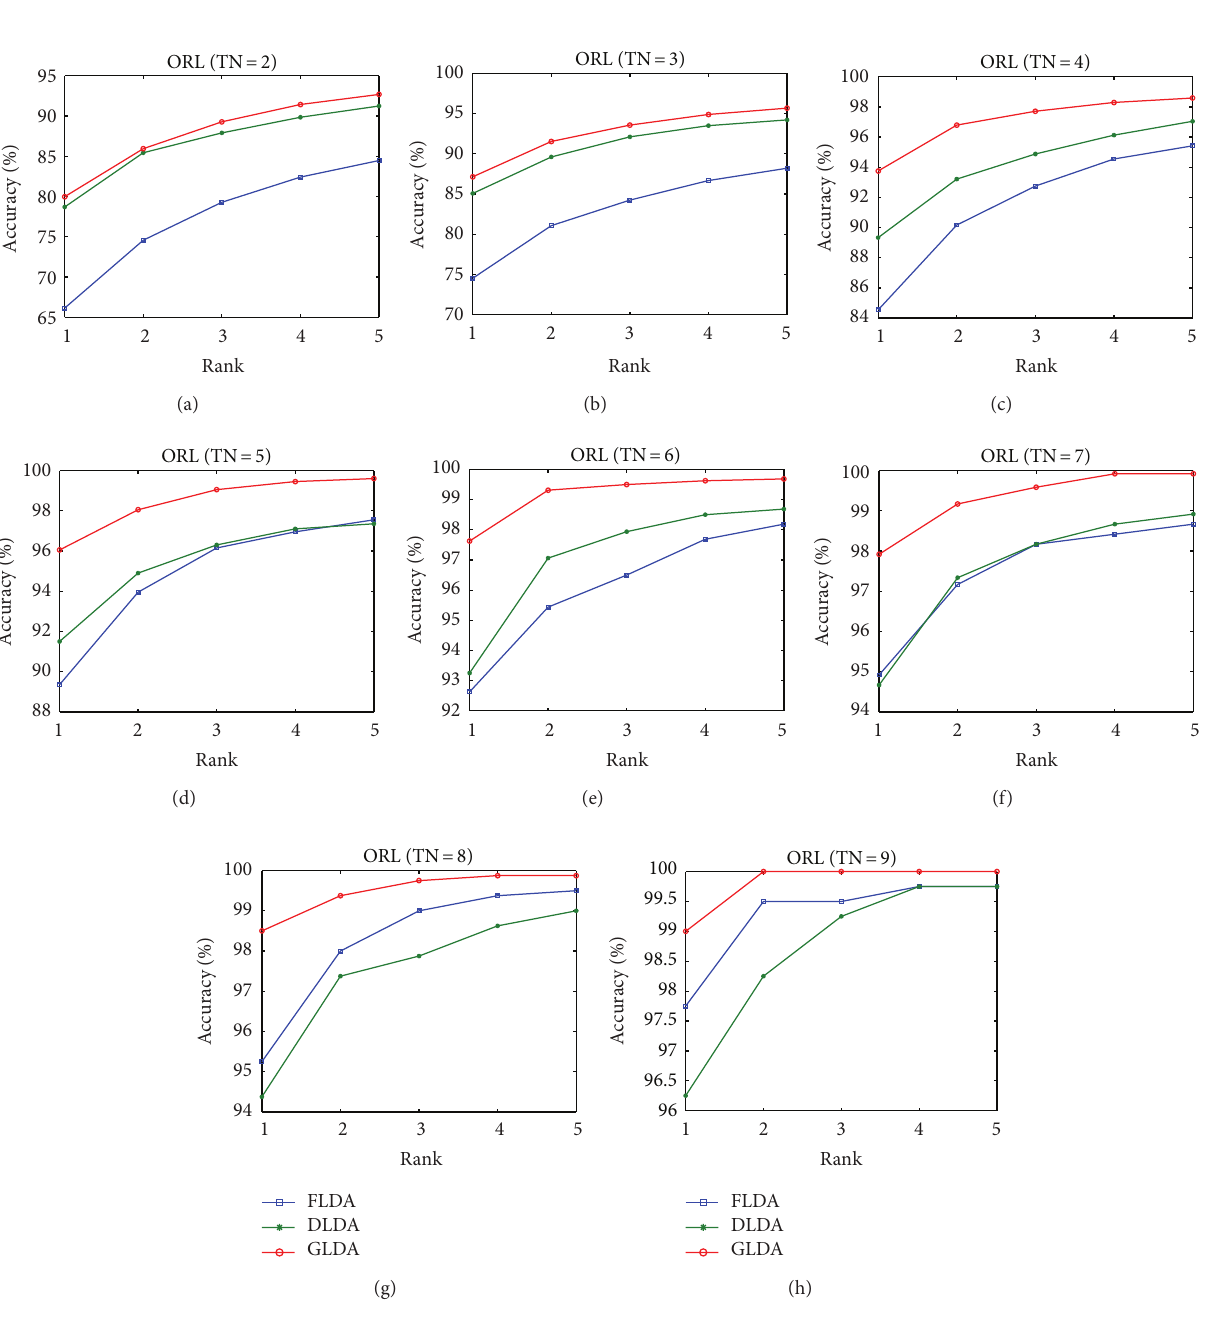
Figure 4: CMC curve comparisons on the ORL